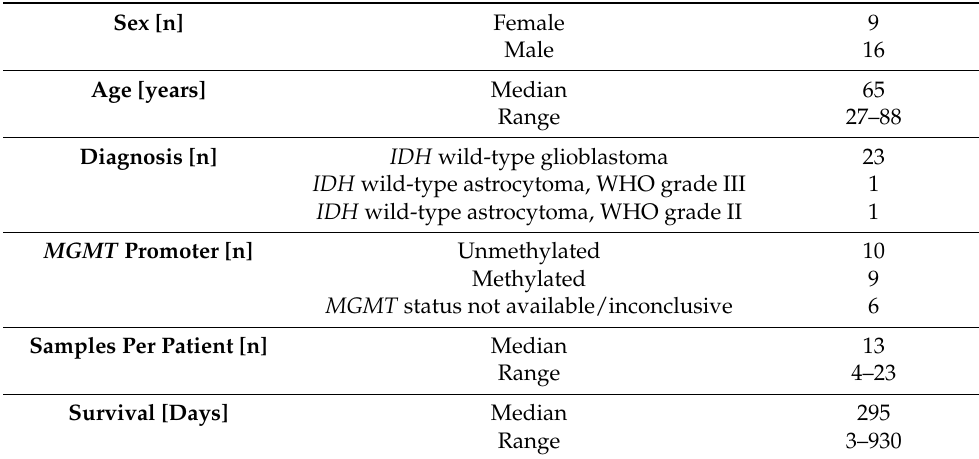
Table 1. Patient and tumor characteristics. IDH , isocitrate dehydrogenase. MGMT , O6-methylguanine- DNA